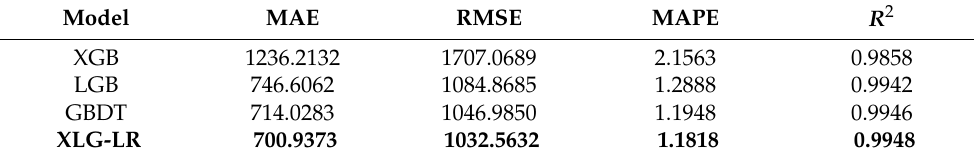
Table 5. Evaluation Index for Power Demand Forecasting of Each Model on a Monthly